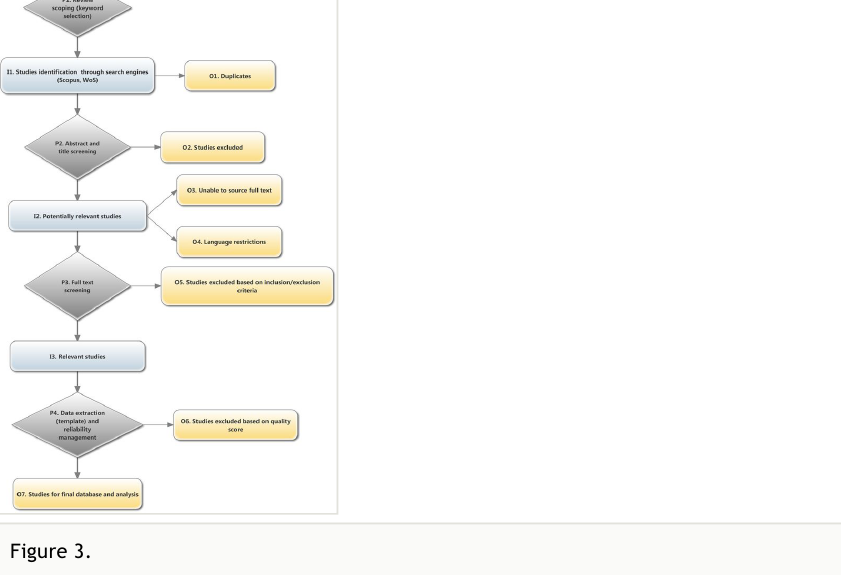
Stages of the systematic review process. Adapted from Collaboration for Environmental Evidence